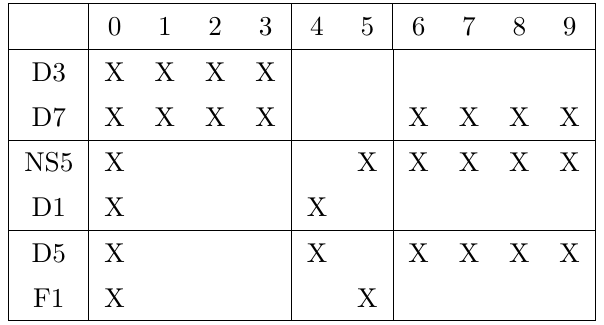
Table 1 . Brane array for 4d N = 2 theories (D3,D7), BPS ’t Hooft loops (NS5,D1) and BPS Wilson loops